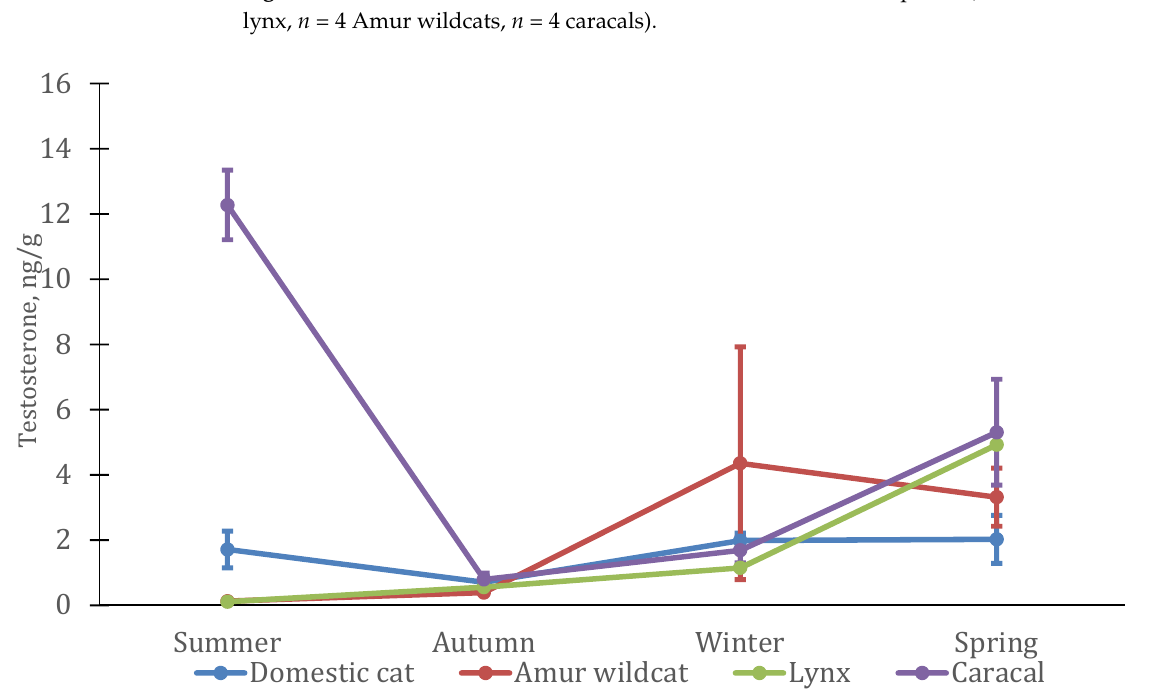
Figure 4. Testosterone concentration in hair from four female felid species ( n = 12 domestic cats, n = 4 lynx, n = 4 Amur wildcats, n = 2 caracals).